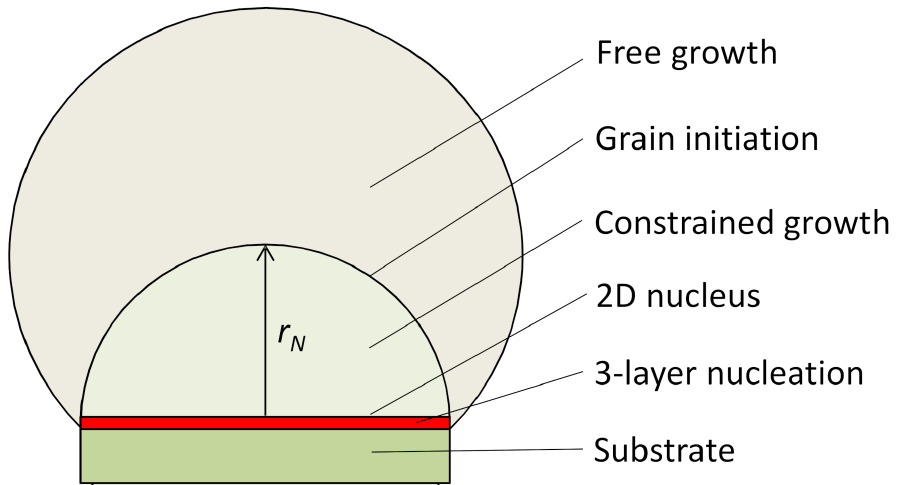
Figure 5. Schematic illustration of the early stages of solidification processes on a single substrate. Heterogeneous nucleation through the 3-layer nucleation mechanism delivers a 2D nucleus. However, further growth is constrained by the curvature of the L/N interface and can only occur by increasing the undercooling. Grain initiation is completed by growing the solid beyond the hemisphere where free growth is possible